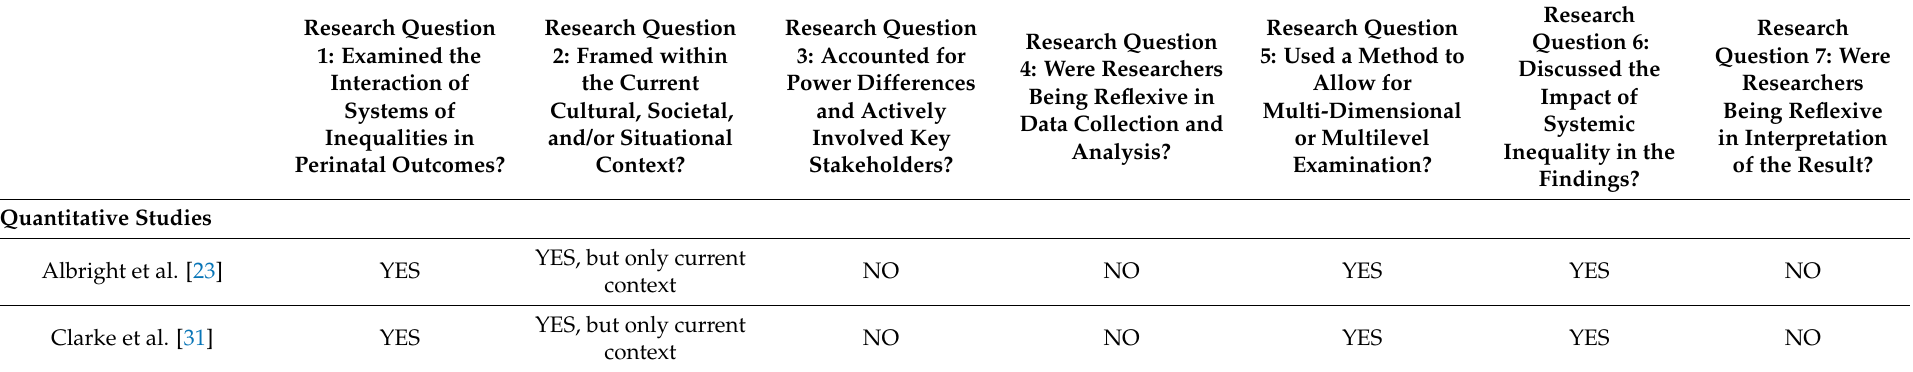
Table 3. Evaluation of Study Using